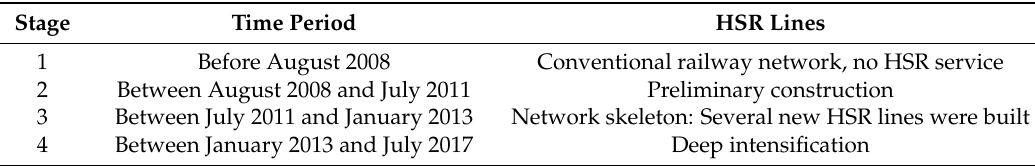
Table 1. Four stages of China’s railway development from 2008–2017.